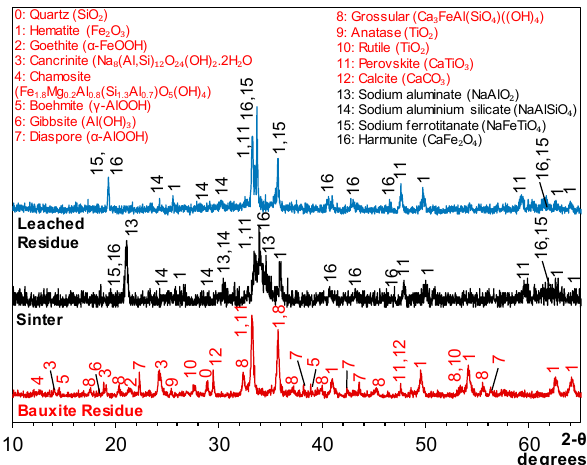
Figure 8. ( a ) Thermodynamic predictions of sinter phase formation and ( b ) results of experimental recovery of Al 2 O 3 , SiO 2 , and Na 2 O at the range of excesses of stoichiometric Na 2 CO 3 additions at 900 °C for 2 h.